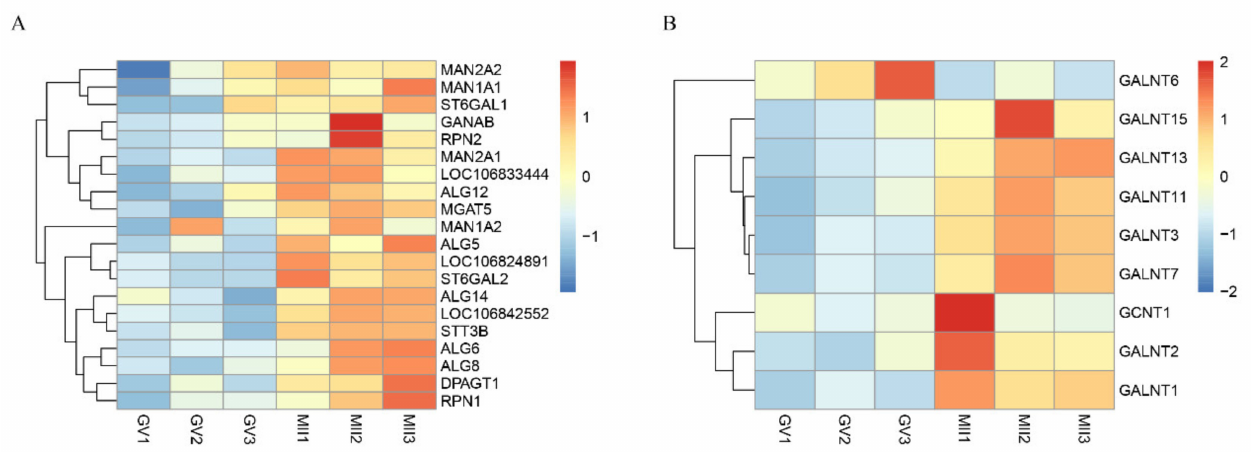
Figure 5. Expression of glycosylation genes. ( A ). Heat map representation of DEGs belonging to the selected N-Glycan biosynthesis enriched by up-regulated DEGs. ( B ). Heat map representation of DEGs belonging to the selected mucin-type O-Glycan biosynthesis enriched by all